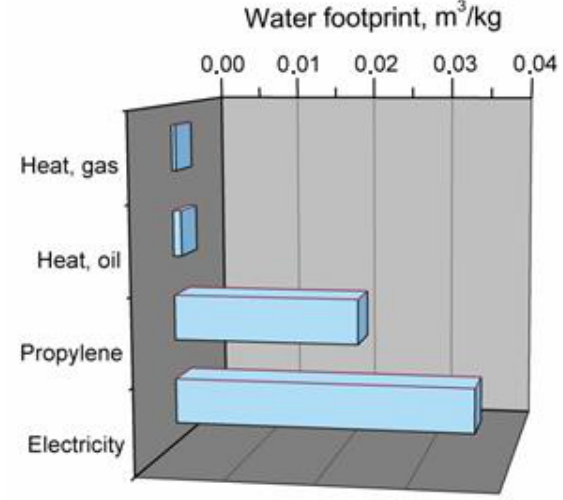
Figure 6. Main components of production system generating water footprint of Figure 6 . Main components of production system generating water footprint of polypropylene.